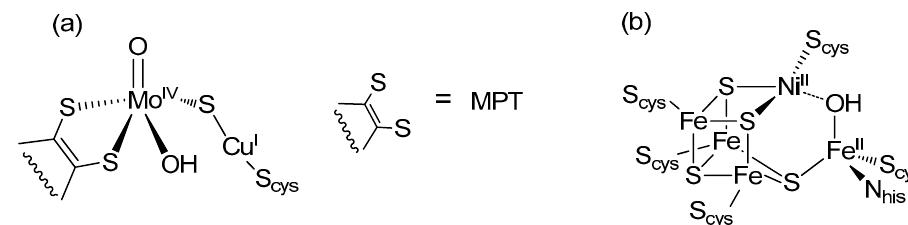
Figure 7. Active sites of ( a ) [MoCu]CODHs with M = Mo and ( b ) [NiFe]CODHs.